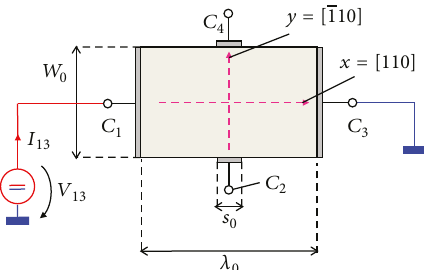
Figure 19: Rectangular Hall plate in (100)-silicon with two perpen- dicular mirror-symmetry axes 𝑥 = [110] and 𝑦 = [110] . An input voltage is forced between contacts 𝐶 1 and 𝐶 3 and an output voltage is tapped between 𝐶 2 – 𝐶 4